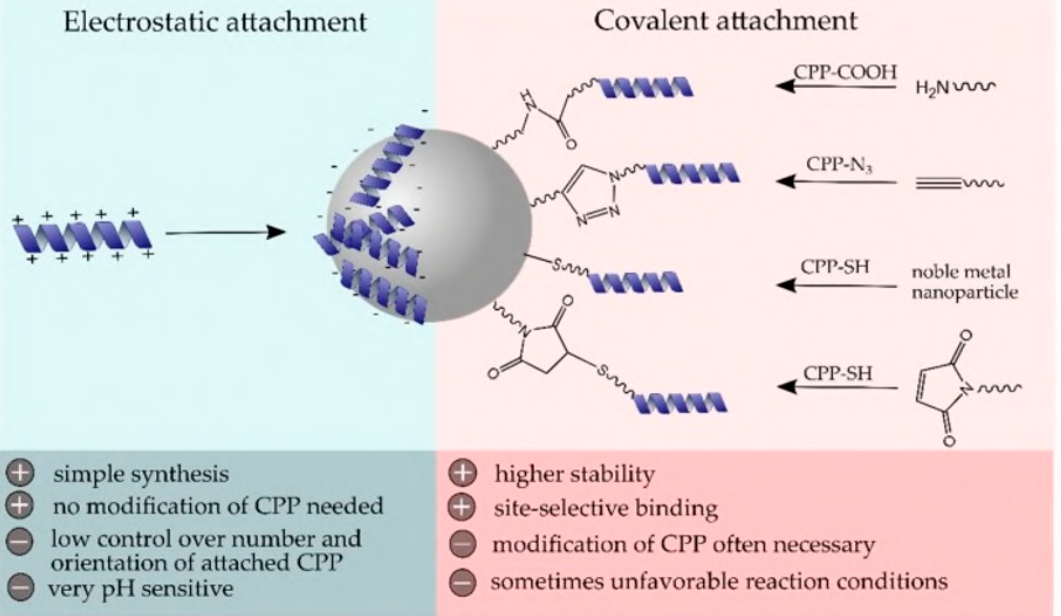
Figure 14. Conjugation of peptides on nanoparticle (NP) by electrostatic immobilization and cova ‐ lent immobilization (adapted with permission from Gessner et al.